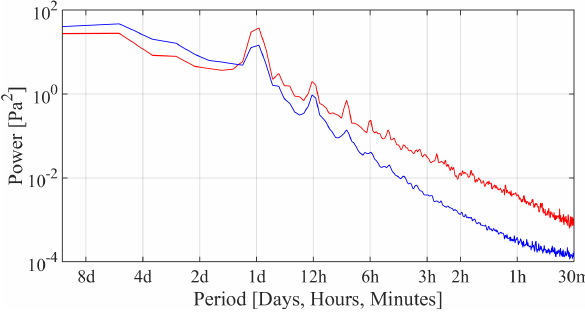
Figure 15. Power spectrum of clusters H1 (in blue) and M1 (in